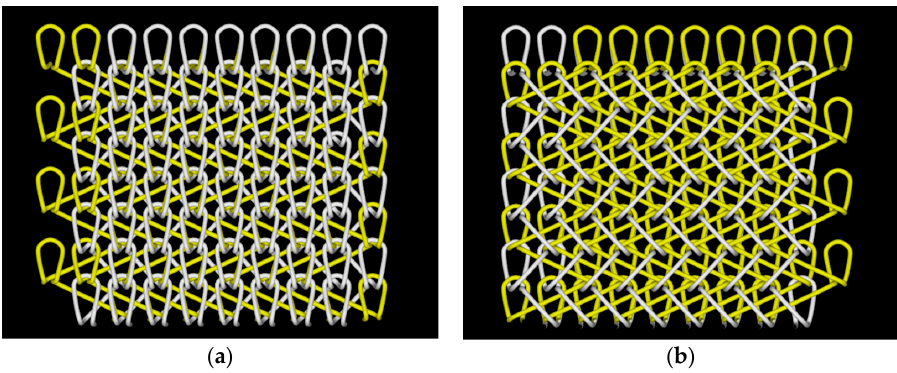
Figure 1. 3D virtual display of warp-knitted fabrics: ( a ) fabric front; ( b ) reverse side of fabric.